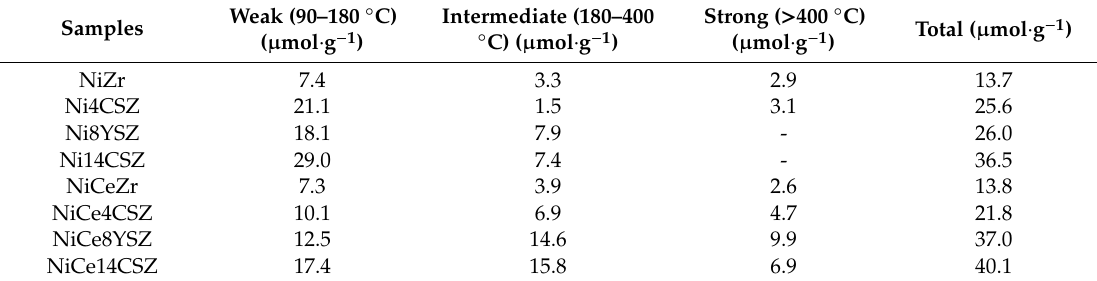
Figure 4. CO 2 desorption profiles. Table 3. Amounts of CO 2 desorbed in the CO 2 -TPD experiments. Values obtained by integration of the deconvoluted profiles in the low, medium and high temperature ranges.